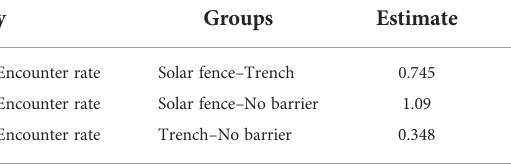
TABLE 2 Table representing the output of post-hoc Games – Howell multiple comparison test to look at the difference between mean encounter rates of all sites. y Groups